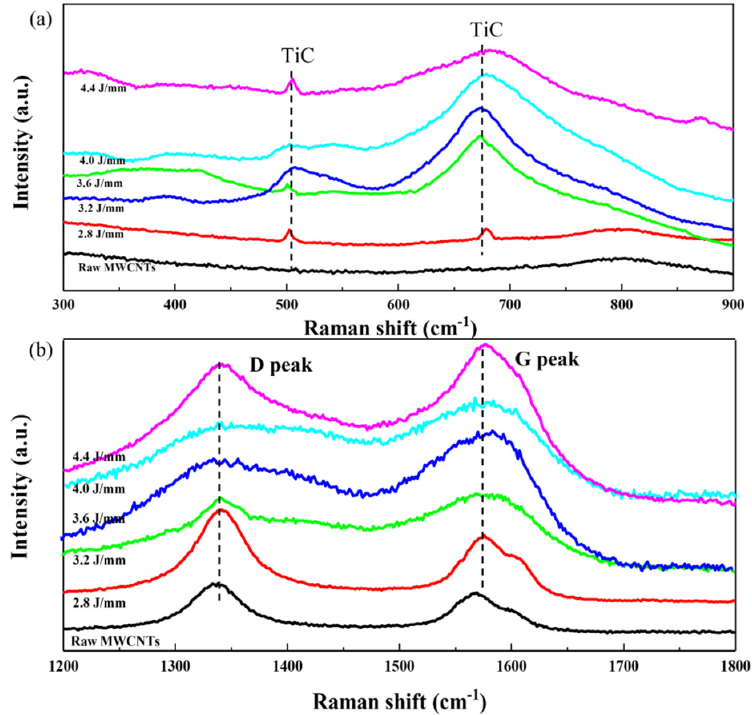
Figure 3. ( a , b ) Raman spectra of thin-walled forming parts at different processing parameters.